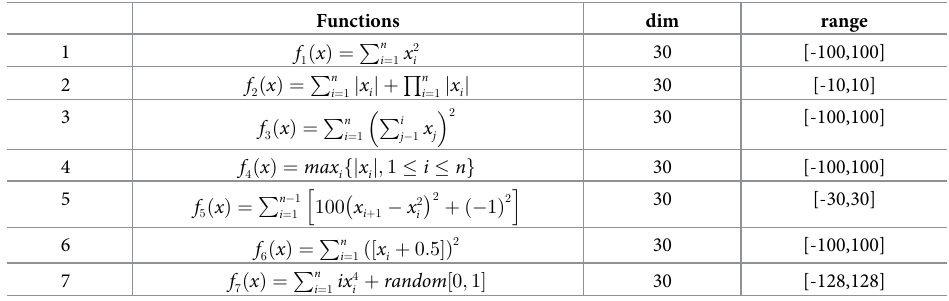
Table 2. Single-modal benchmark